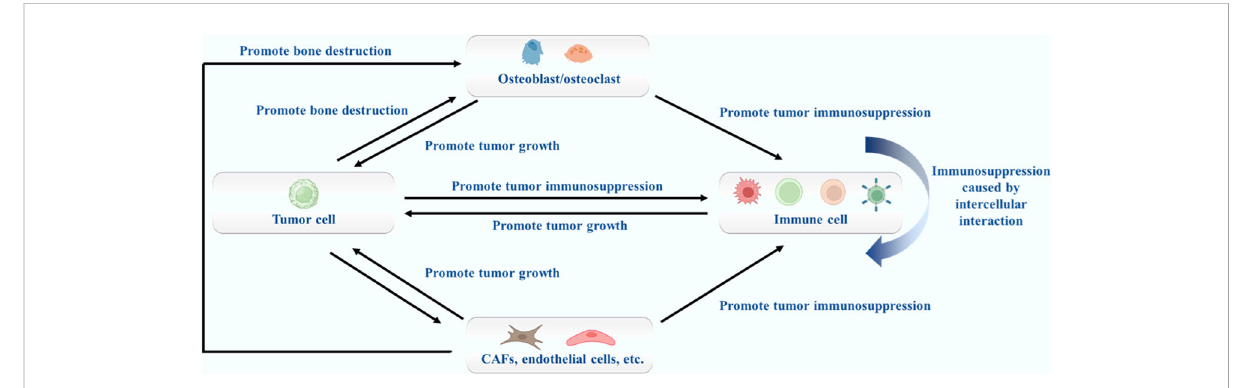
FIGURE 1 The role of different cell types in bone